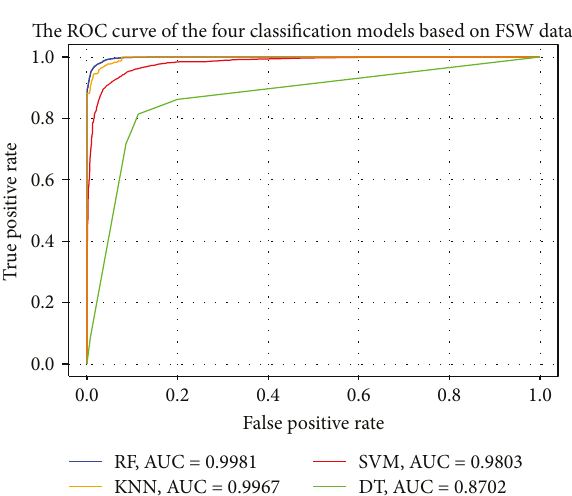
Figure 5: ROC curve of di ff erent classi fi ers for FSW dataset.